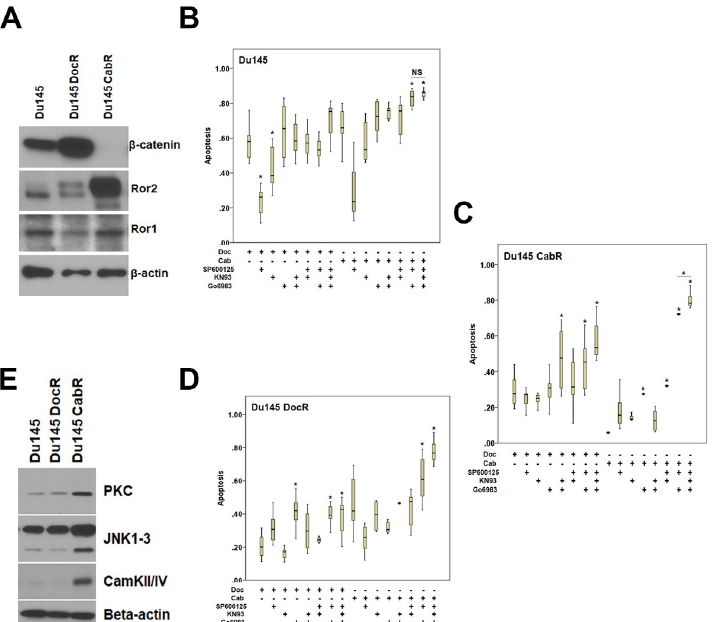
Fig 6. Role of the Wnt pathway in taxane resistance. (A) Representative expression levels of the β -catenin, Ror1, and Ror2 proteins in age-matched and taxane resistant Du145 cells. In these experiments, three independent protein cell extracts were tested. (B-D ) In vitro pharmacological study. TUNEL apoptosis assay was performed in age-matched (B) and taxanes-resistant (C-D) Du145 cells treated with Go¨6983 (PKC inhibitor, 1 μ M, 2hrs), SP600125 (JNK inhibitor, 30 μ M, 2hrs), and KN93 (CamKII/IV inhibitor, 10 μ M, 4hrs) combinations followed by taxanes (50nM, 24hrs). (E) Expression level of PKC, JNK and CamkII/IV proteins showing a specific up-regulation of all three kinases in CabR when compared to age-matched and DocR cells. Beta-actin was used to control the loading.